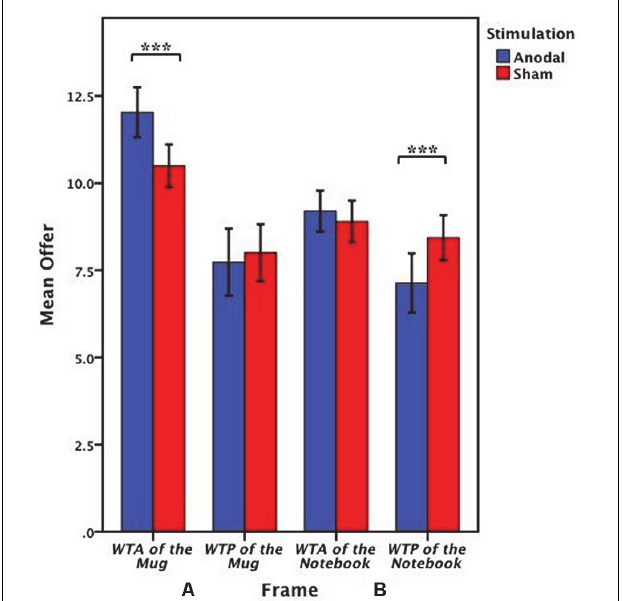
FIGURE 9 | Data of offer in the valuation task (Experiment 2). (A) The mean offer of the mug across anodal or sham stimulation in each frame. (B) The mean offer of the notebook across anodal or sham stimulation in each frame. Error bars indicate 95% confidence intervals. Asterisks indicate statistically significant difference between the